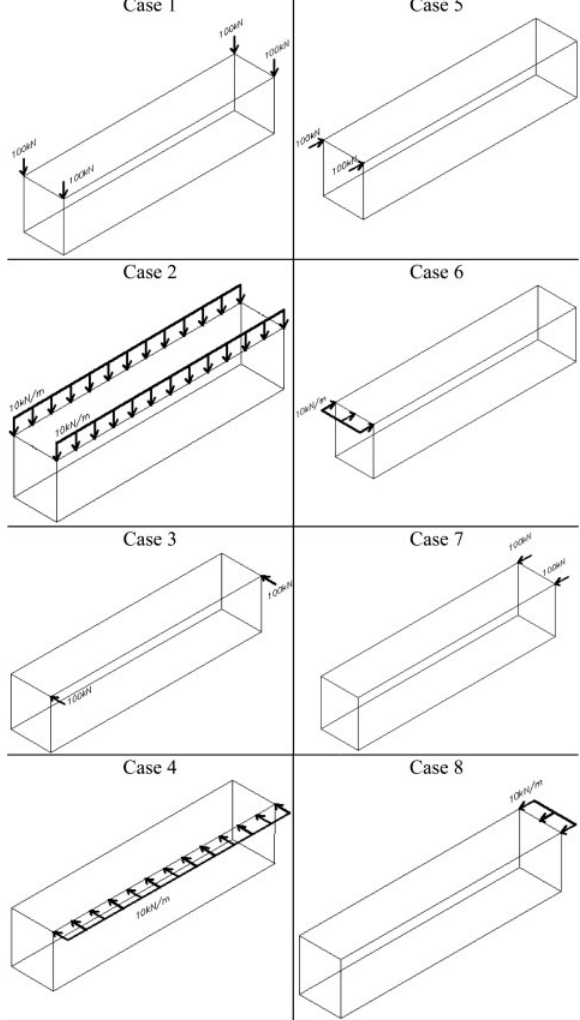
Table 6. Load cases